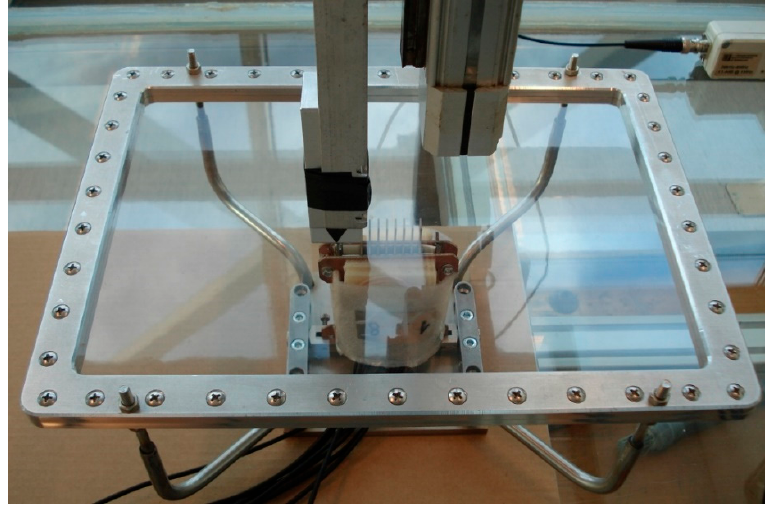
Figure 18. View of PVC film mounting bracket and acoustic part of experimental setup.